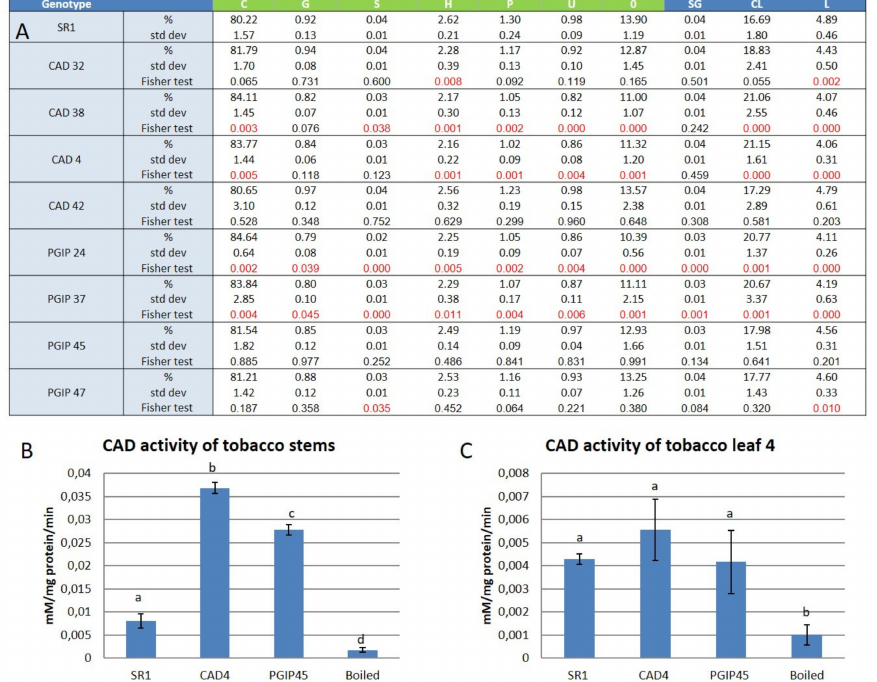
Figure 1. ( A ): Table of the lignin relative content and composition of the harvested tobacco leaves. Results are presented as the percentage of the total spectra recorded. Each percentage is the average of four biological repeats of four different leaves, showing standard deviation. A two-way ANOVA followed by a Fisher least significant difference (LSD) post-hoc test showed if the variations of the component analysed using Py-GC–MS between the different tobacco transgenic lines versus the wild type SR1 were significant with p ≤ 0.05. C:Carbohydraterelatedcomponents; G:Guaiacyl; S:Syringyl; H:p-hydroxyphenol;